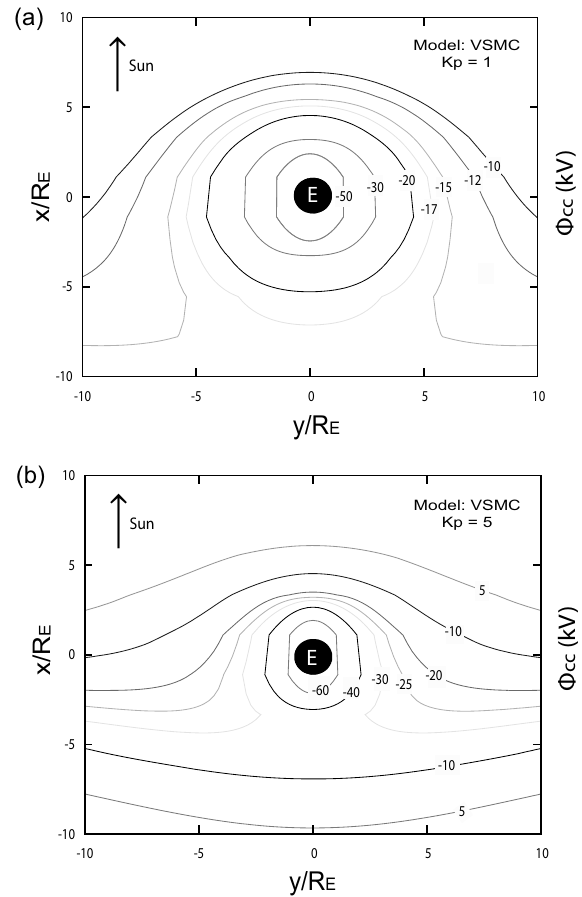
Figure 4. Contours of the convection and corotation electric poten- tial over the GSM x − y plane on the equatorial level ( z = 0), as calculated with the VSMC model, for γ = 2, υ 1 = 0 . 045kVm − 2 , υ 2 = 0 . 0093, υ 3 = − 0 . 159 and (a) Kp = 1 and (b) Kp =